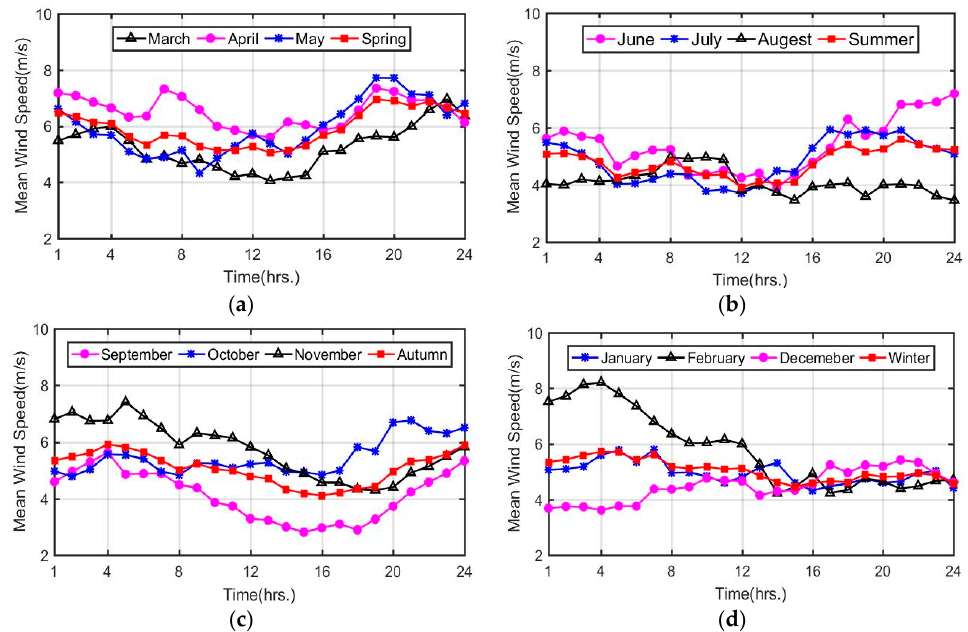
Figure 5. Wind speed variation during each day: ( a ) spring and its three months; ( b ) summer and its three month; ( c ) autumn and its three month; ( d ) winter and its three months.